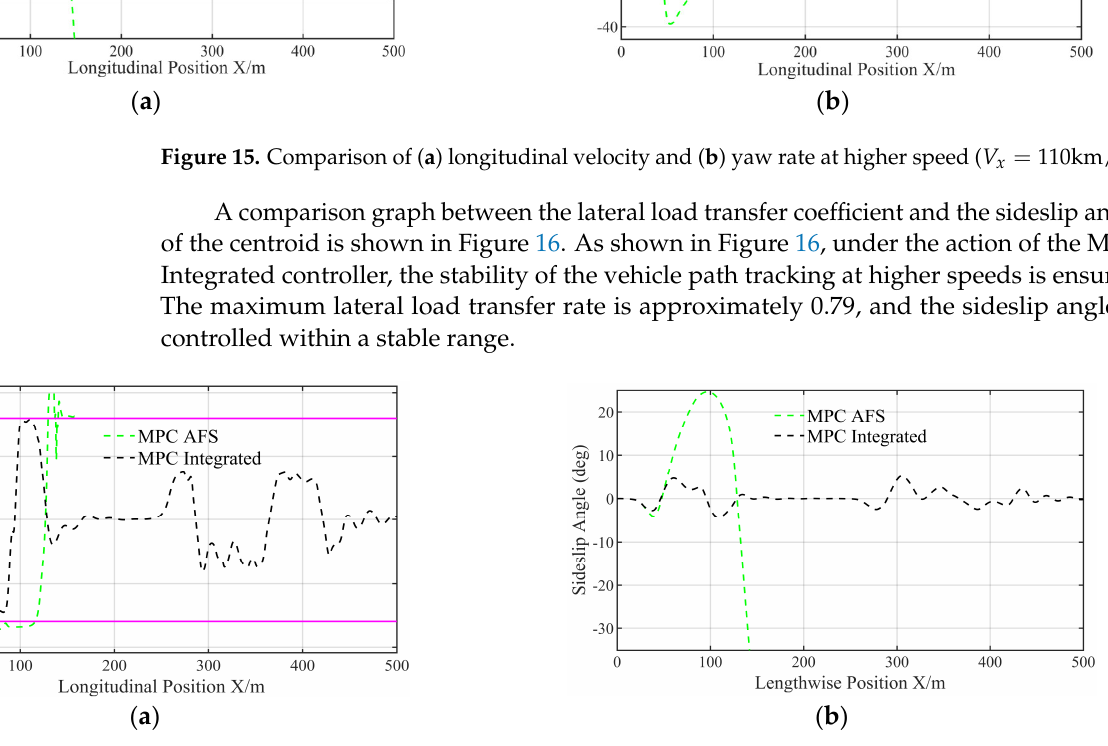
Figure 16. Comparison of ( a ) lateral LTR and ( b ) sideslip angle of the centroid at higher speed ( V x = 110km/h ).